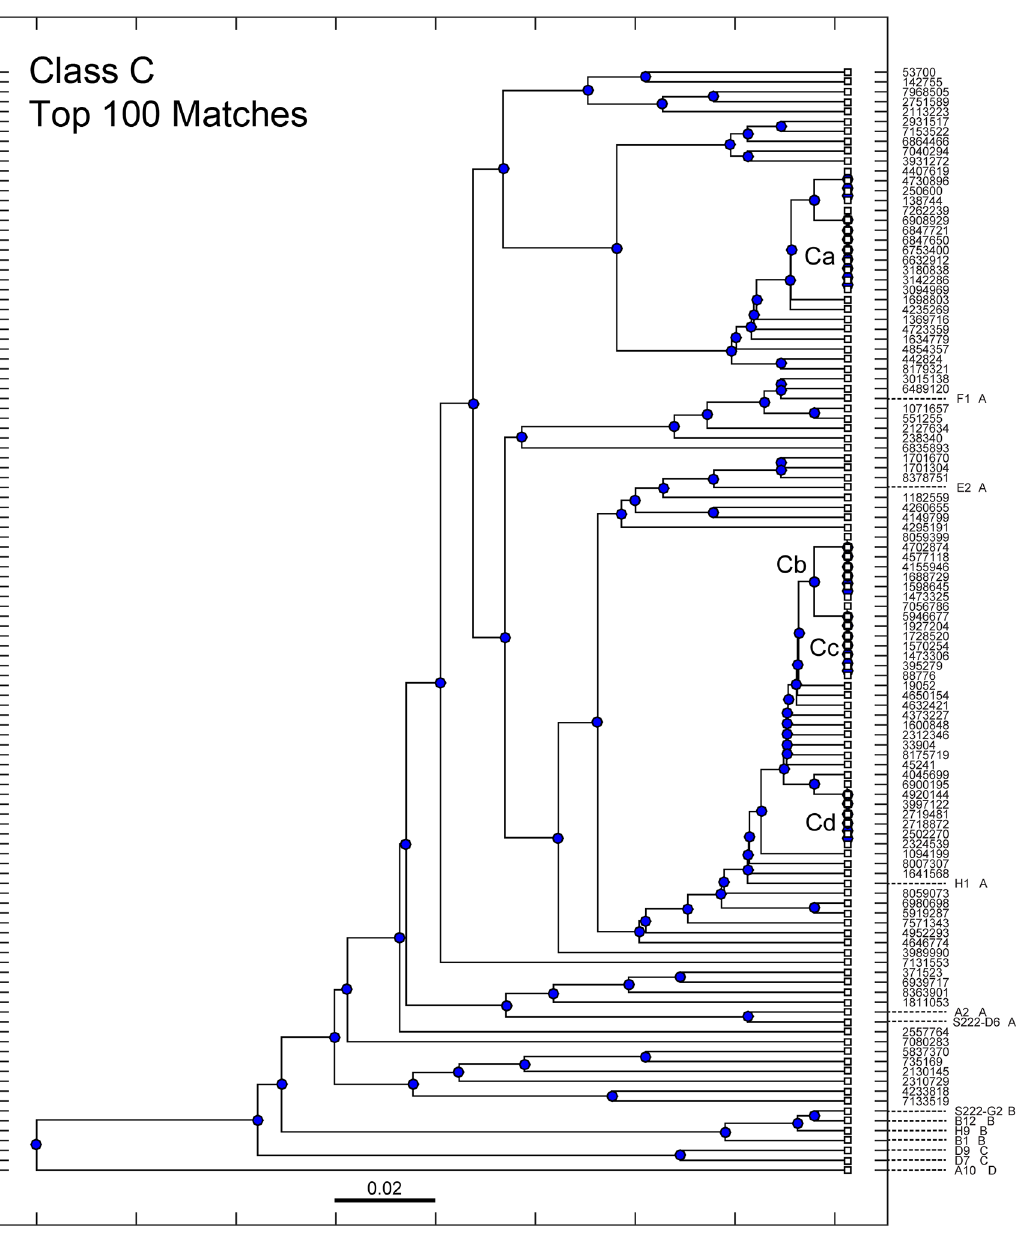
Fig 4. Phylogenetic tree of the top 100 sequences for Class C. Library sequences obtained in a search query using sequences from Class C were arranged in a phylogenetic tree denoting sequence similarity. The scale bar represents a 2% difference in the amino acid sequence. Previously identified sequences in Classes A through D were included and denoted appropriately within the tree. Sequences from the library present in multiple copies are denoted as Ca, Cb, Cc,